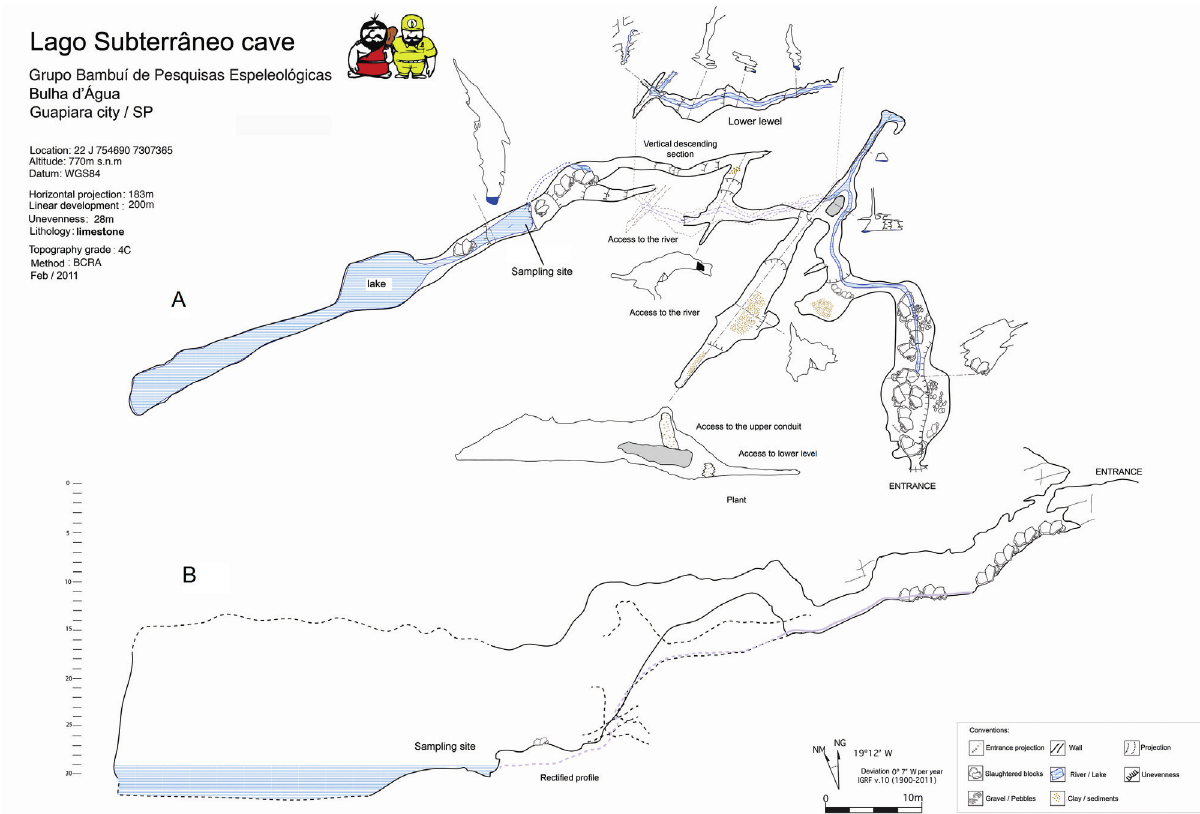
Figure 2. A, Floor plan; B, longitudinal section maps of “Lago Subterrâneo” cave, with indication of sampling site. This map was drawn and produced by Grupo Bambuí de Pesquisas Espeleológicas and used herein by kind permission.